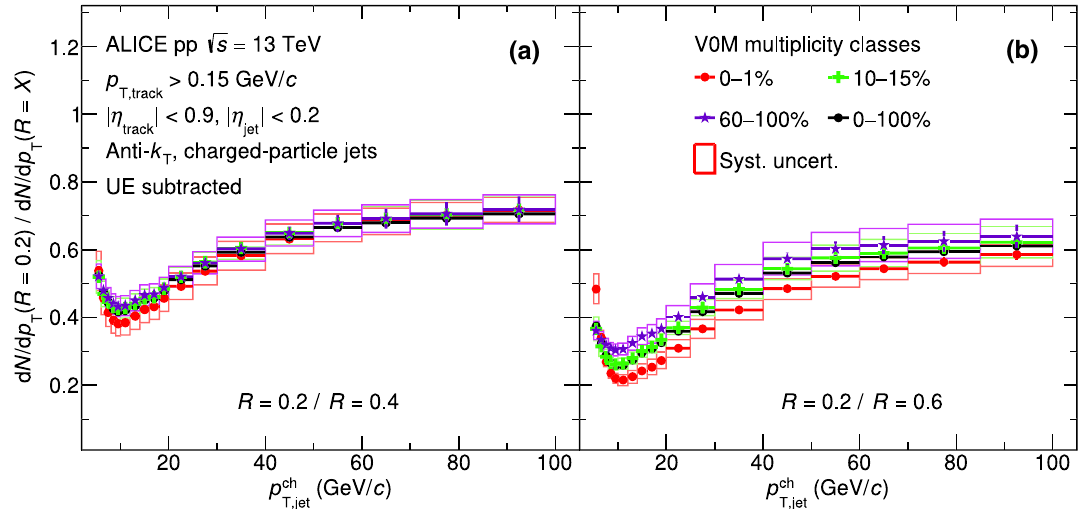
Fig. 19 Comparison of jet production ratios of R = 0 . 2 to R = 0 . 4 (a) , R = 0 . 6 (b) in three multiplicity intervals (0–1%, 10–15% and 60–100%) and compared with PYTHIA simulations. Statistical and systematic uncertainties are shown as vertical error bars and boxes around the data points,